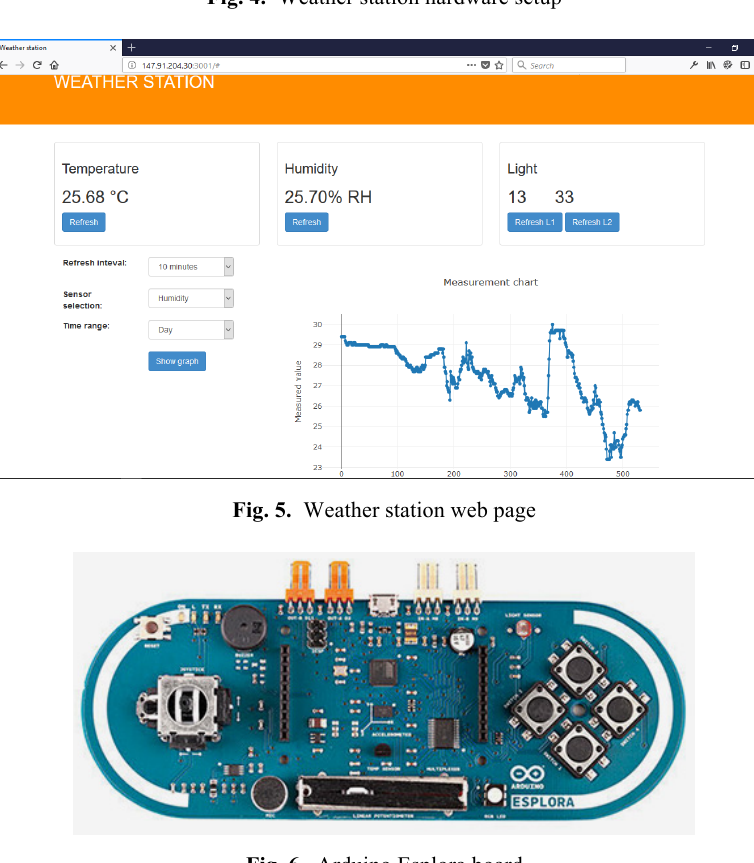
Fig. 6. Arduino Esplora